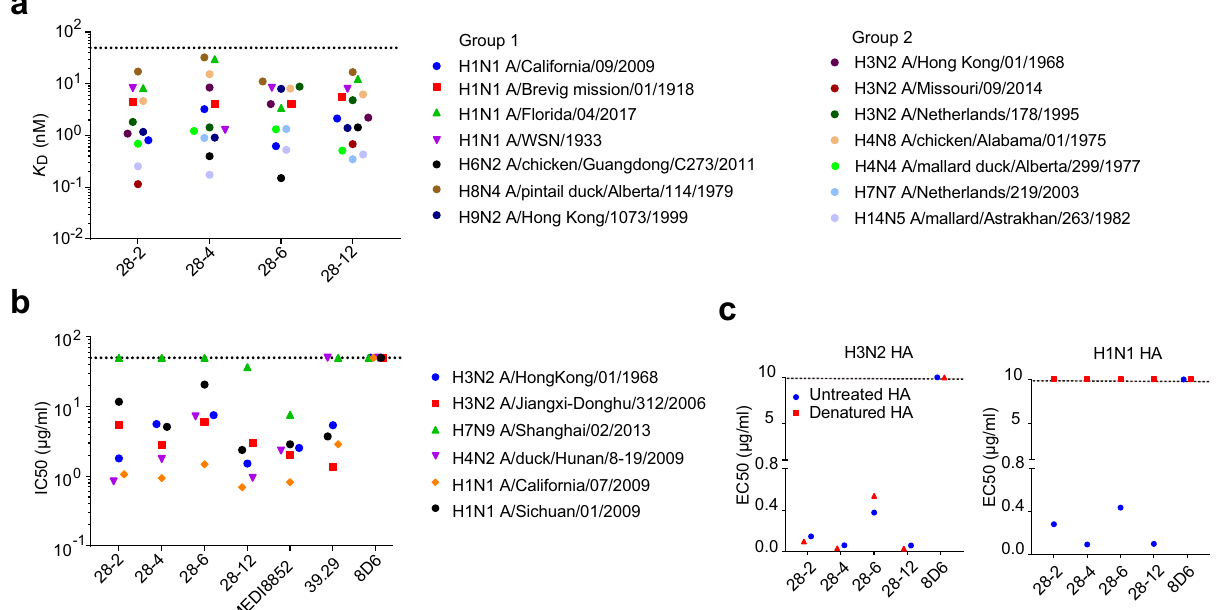
Fig. 2 V H 3-48/V K 1-12 lineage antibodies broadly bind and neutralize multiple in fl uenza subtypes. a Binding af fi nity ( K D ) of each mAb to HA proteins from a panel of group 1 and group 2 in fl uenza A isolates as measured by BLI. Dashed line indicates 50 nM. b In vitro neutralizing activity of each mAb against multiple strains of H1, H3, H4, and H7 subtype IAVs, shown as IC50 values. MEDI8852 and 39.29 were included as positive controls while 8D6 was the negative control. Dashed line indicates 50 μ g/ml. The hosts of non-human infecting IAV strains have been noted in the full name of IAV strains, while the other IAV strains without host annotation are human infecting. c ELISA binding EC50 values of each mAb to denatured or untreated HAs of H3N2 and H1N1. Representative data are shown from two independent